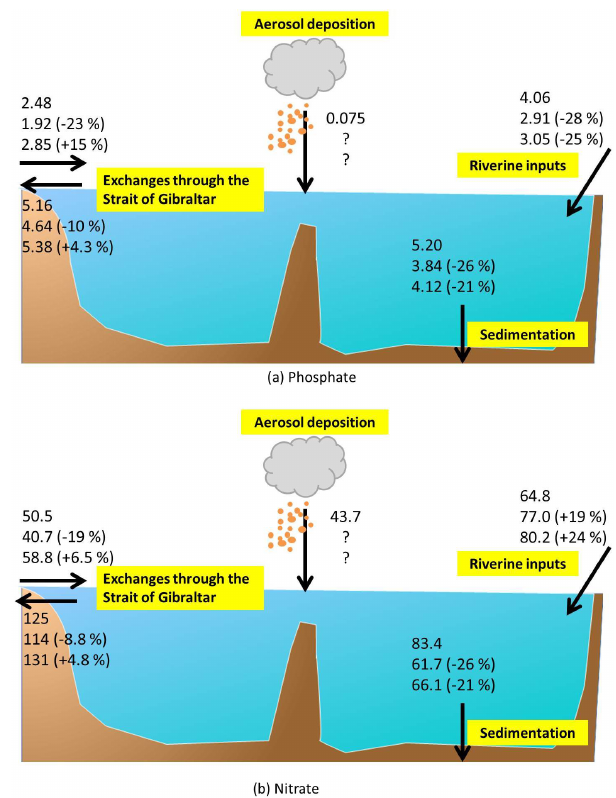
Figure 18. Schematic diagrams illustrating the Mediterranean bud- gets of phosphate and nitrate. For each component, the three lines represent the average fluxes (in Gmolyr − 1 ) over the periods 1980– 1999, 2030–2049, and 2080–2099, and numbers in parenthesis in- dicate the percentage difference from the 1980–1999